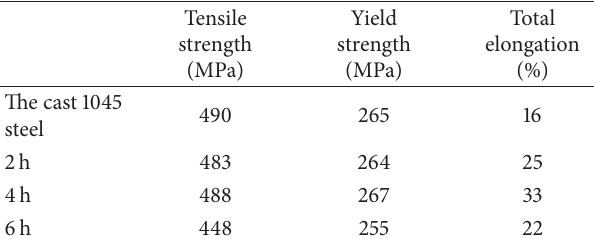
Table 3: Tensile properties of the 1045 steel without and with annealing for different